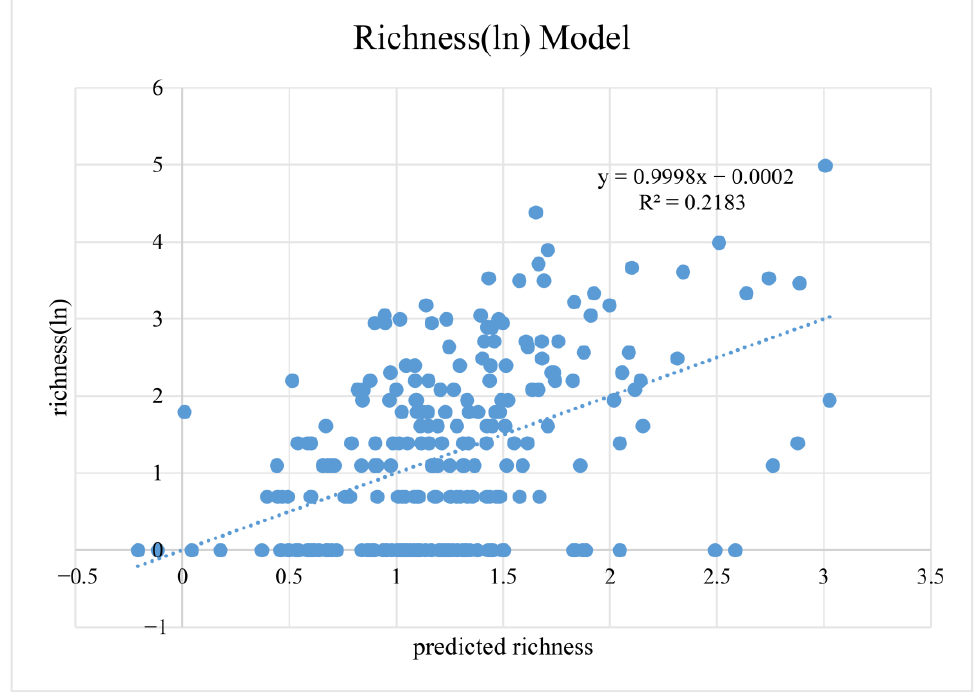
Figure 6. Richness (natural logarithm) model of Tipulidae in mountainous regions of the Qinghai- Tibet Plateau and its surrounding areas.